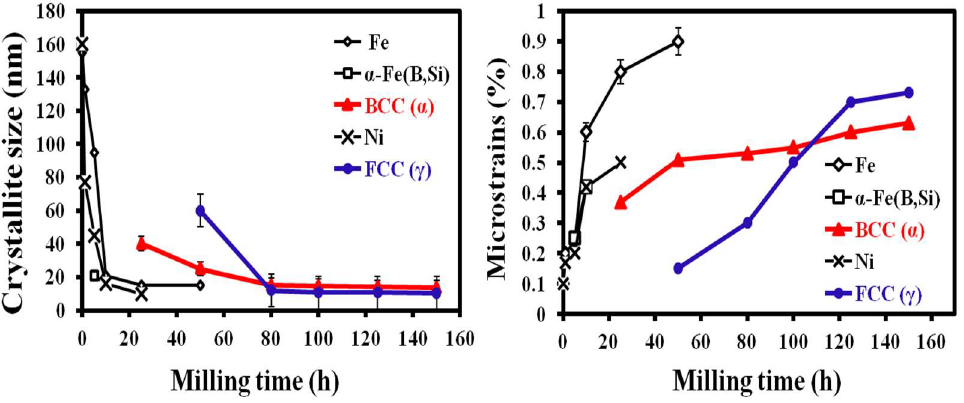
Figure 4. Microstructure parameters as a function of milling time .